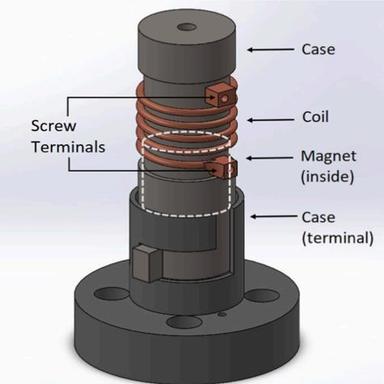
3D model of the sensor.